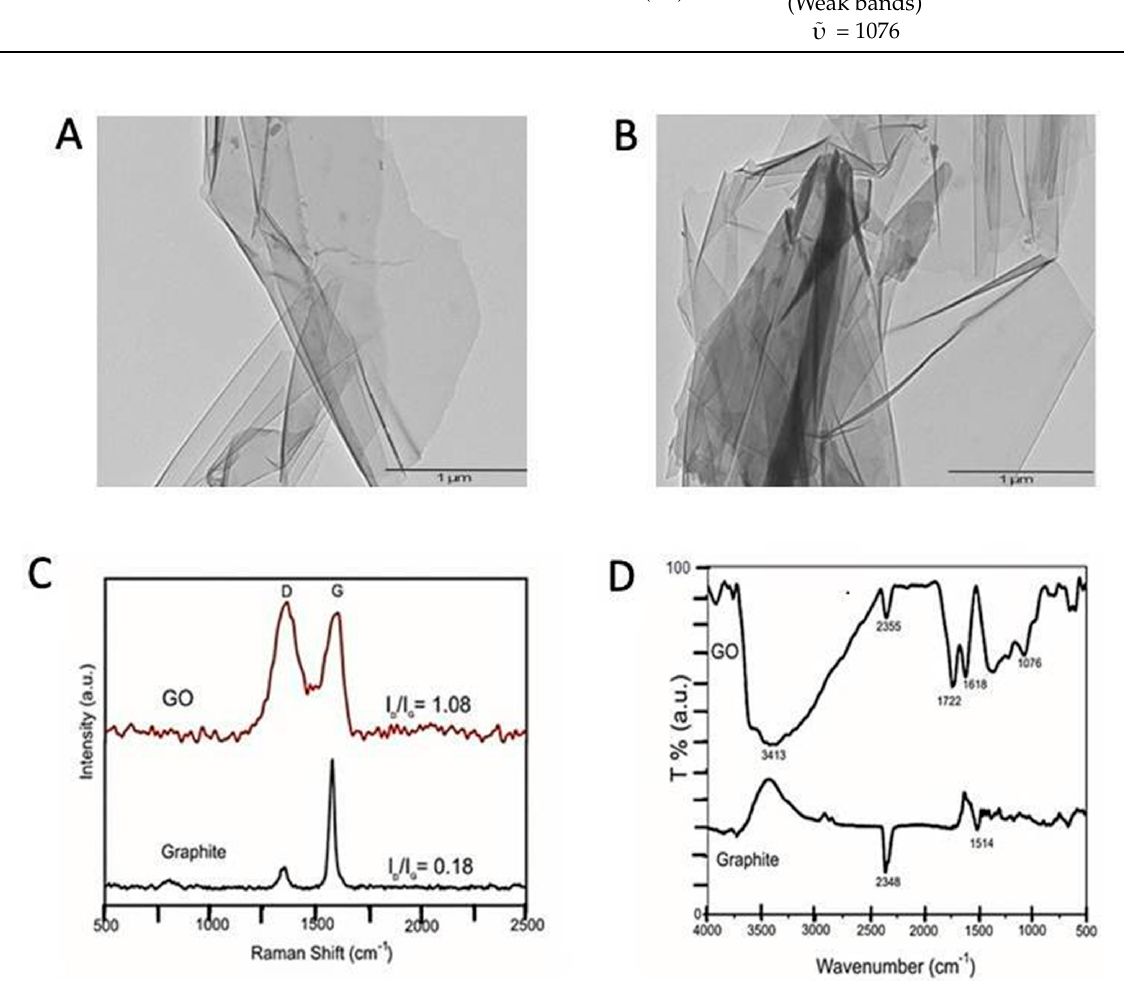
Figure 1. GO characterization: ( A , B ) TE_micrographs of GO; ( C ) Raman spectrum for both carbon-based materials; and ( D ) FTIR spectrum profile for GO and graphite samples, respectively.